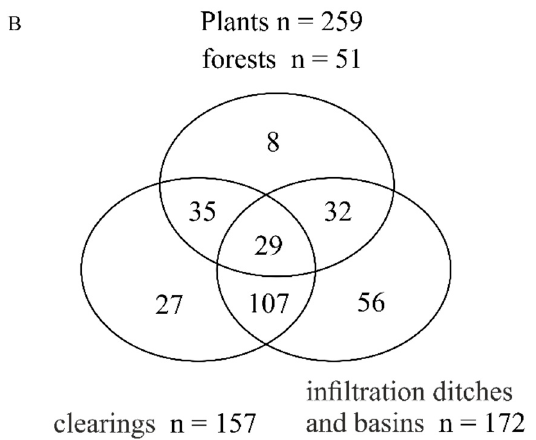
Figure 2. Venn diagram presenting the richness of shared and exclusive ( A ) bee and ( B ) plant spe- cies.